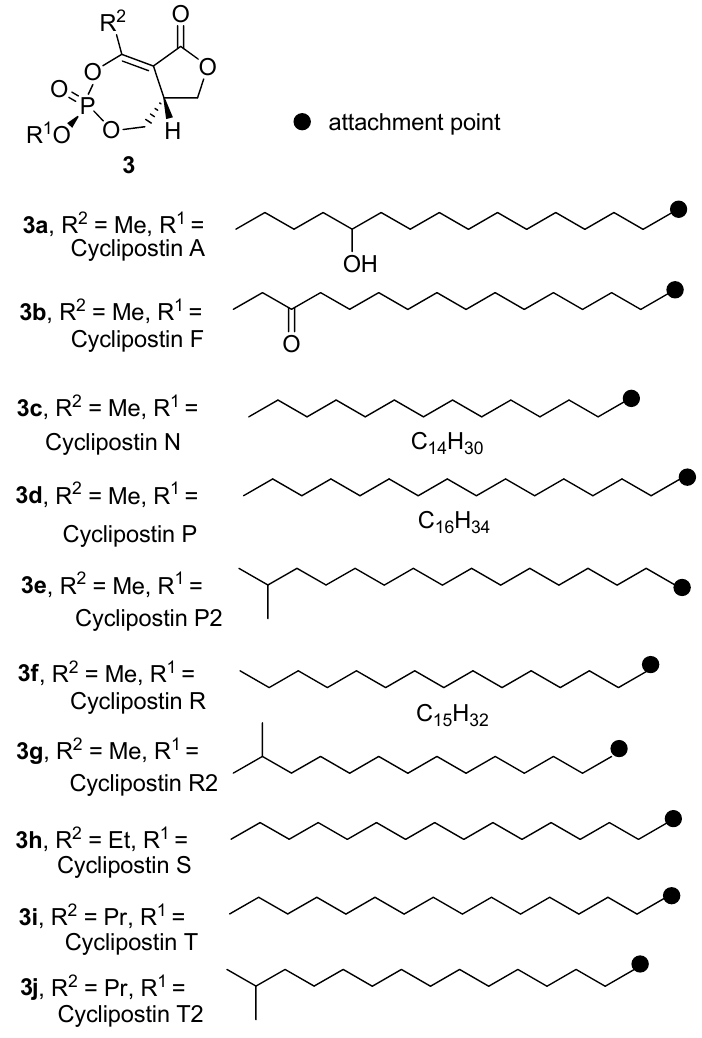
Figure 2. The cyclipostins. Figure 2. The